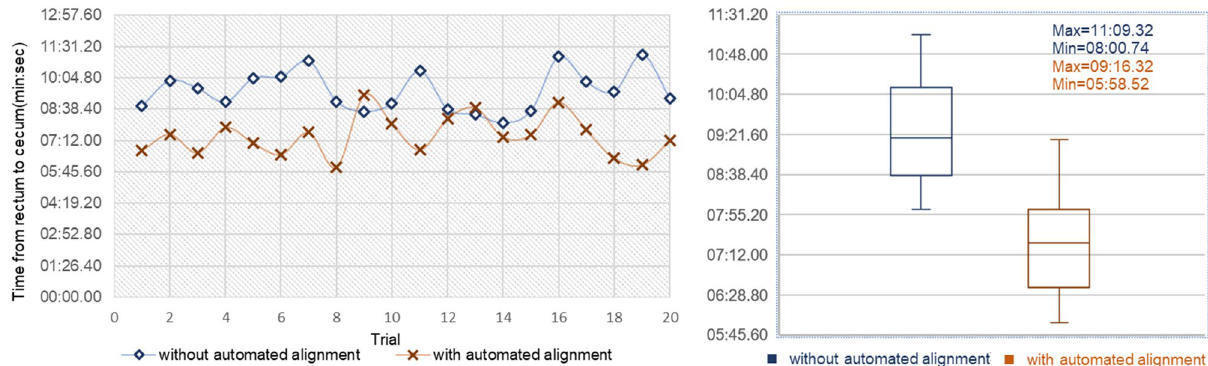
Figure 3. Intubation time from the rectum to cecum. Manual navigation and semi-automated navigation were represented by blue and brown lines, respectively. The average cecal intubation time of manual navigation and semi-automated navigation were 9 min 28.41 s and 7 min 23.61 s,